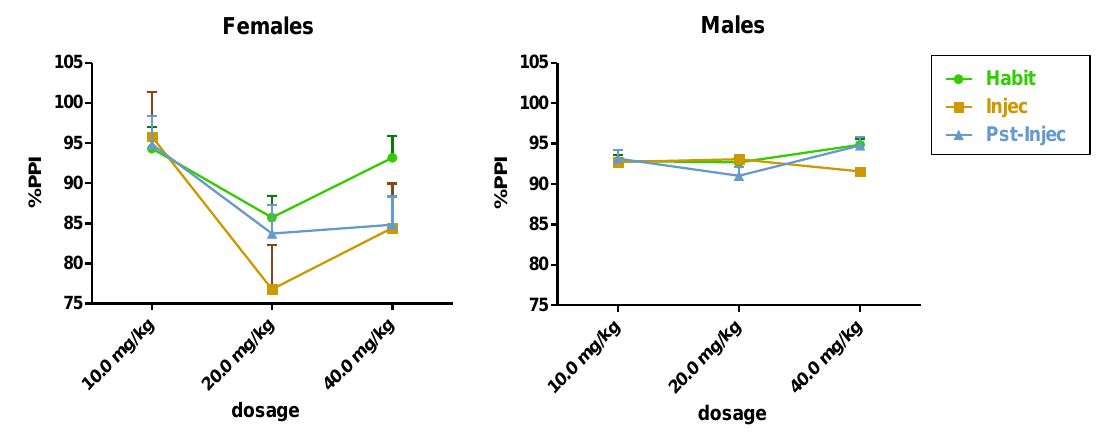
Figure 3. (Spring, Group B) ( n = 6) shows the effect of cocaine on females (left) and males (right). Statistically significant differences occurred in the interaction between and within dosage and gender (sex).